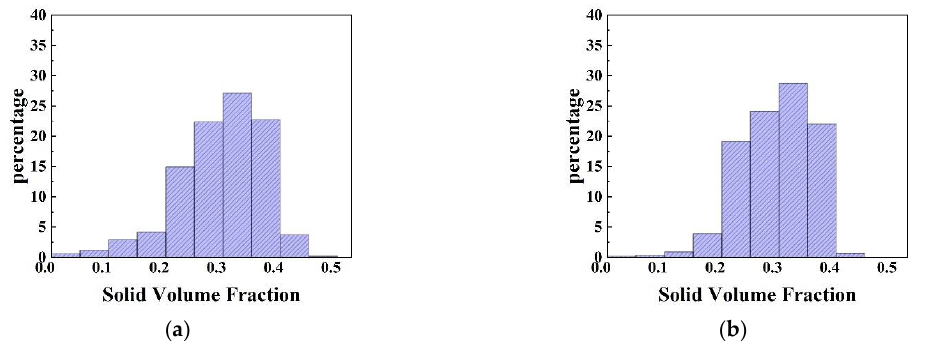
Figure 16. Contour plots of solid distribution for DRFTBI at different rotational speeds. ( a ) 90 rpm; ( b ) 120 rpm. (Rotational speed: 120 rpm; solid loading: 30%; connection strap length: 1.2 Hs; plane: X = 0.)